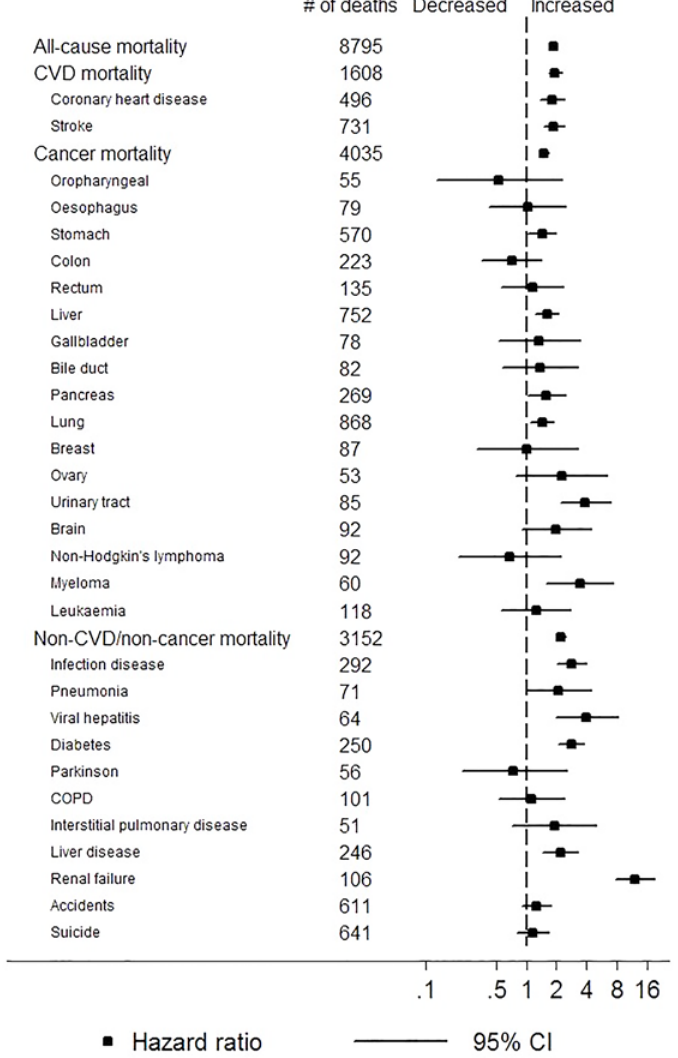
Fig 4. Adjusted hazard ratios of cause-specific mortality for positive dipstick proteinuria ( ≥ + vs. none/